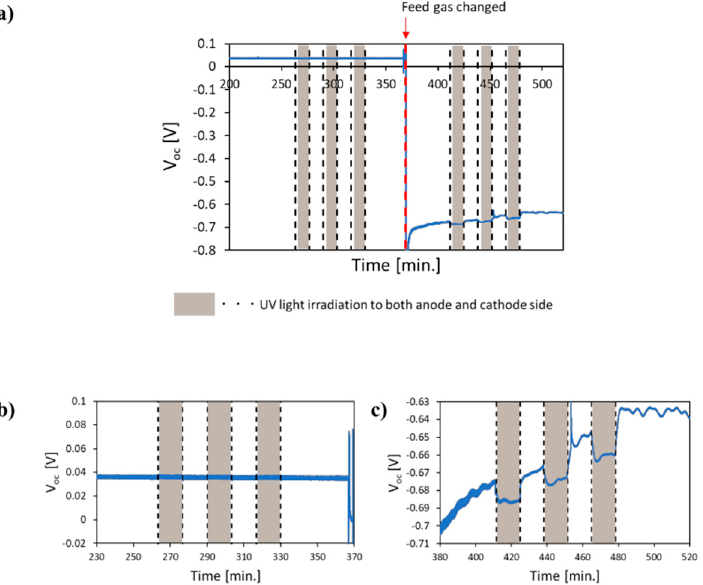
Figure 38. ( a ) Result of the open-circuit voltage measured under an Ar flow into the anodic and cathodic sides with the light on and off. The feed gas was changed to CH 4 into the anodic side and CO 2 into the cathodic side at 370 nm. ( b , c ) The expanded view of ( a ). Reprinted from [52]. Copyright 2020 by John Wiley & Sons, Inc.